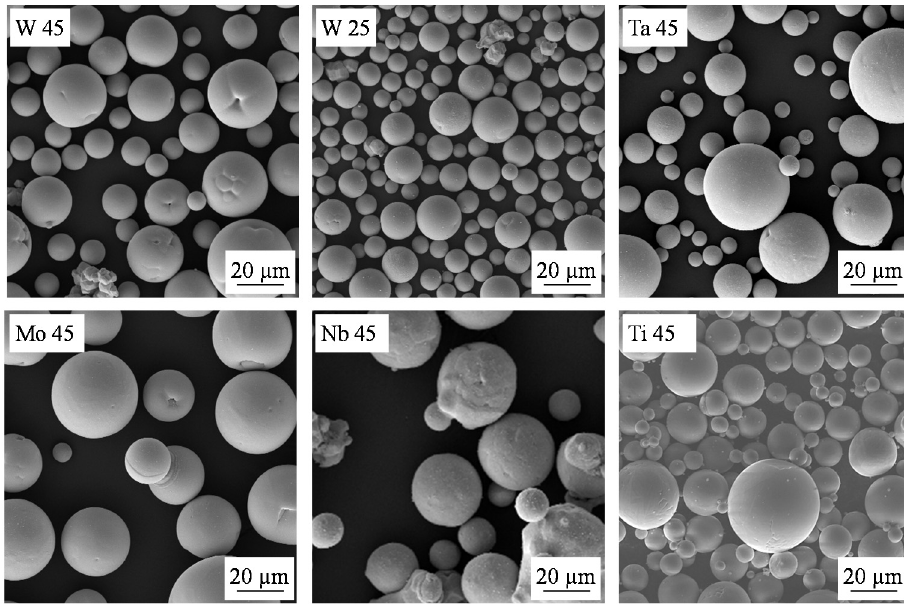
Figure 2. Scanning electron microscopy (SEM)-images of the powders used in this work; SEM type: Zeiss Merlin. Table 1. Particle size distribution determined by laser diffraction.